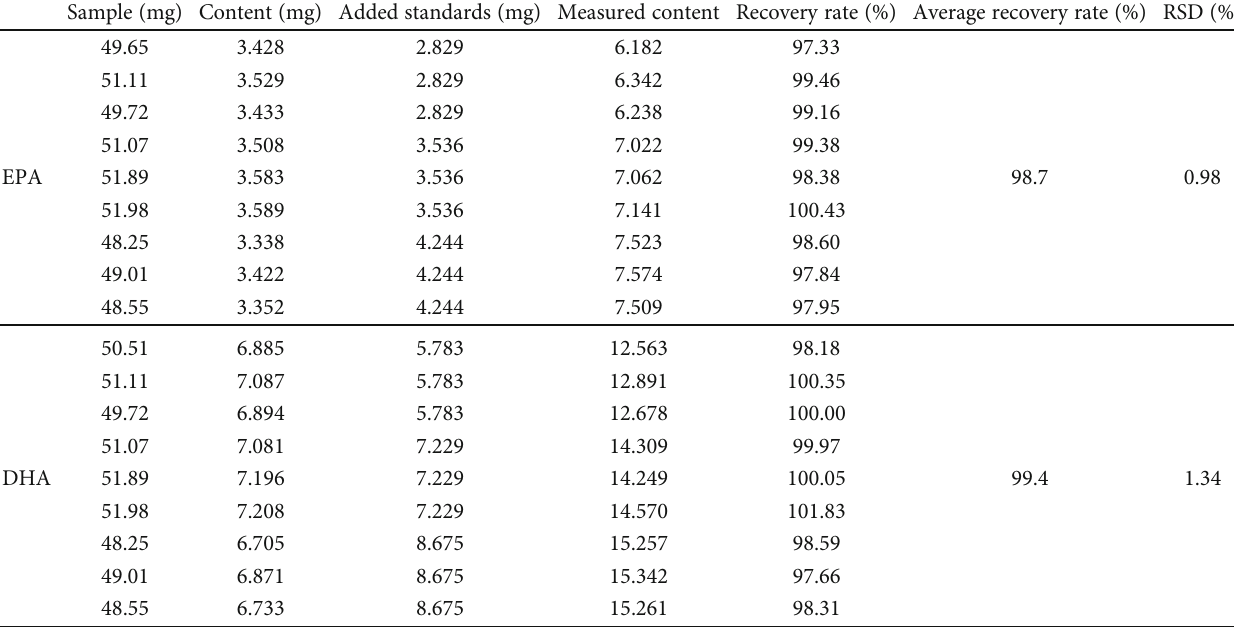
Table 2: Recovery rates of EPA and DHA.